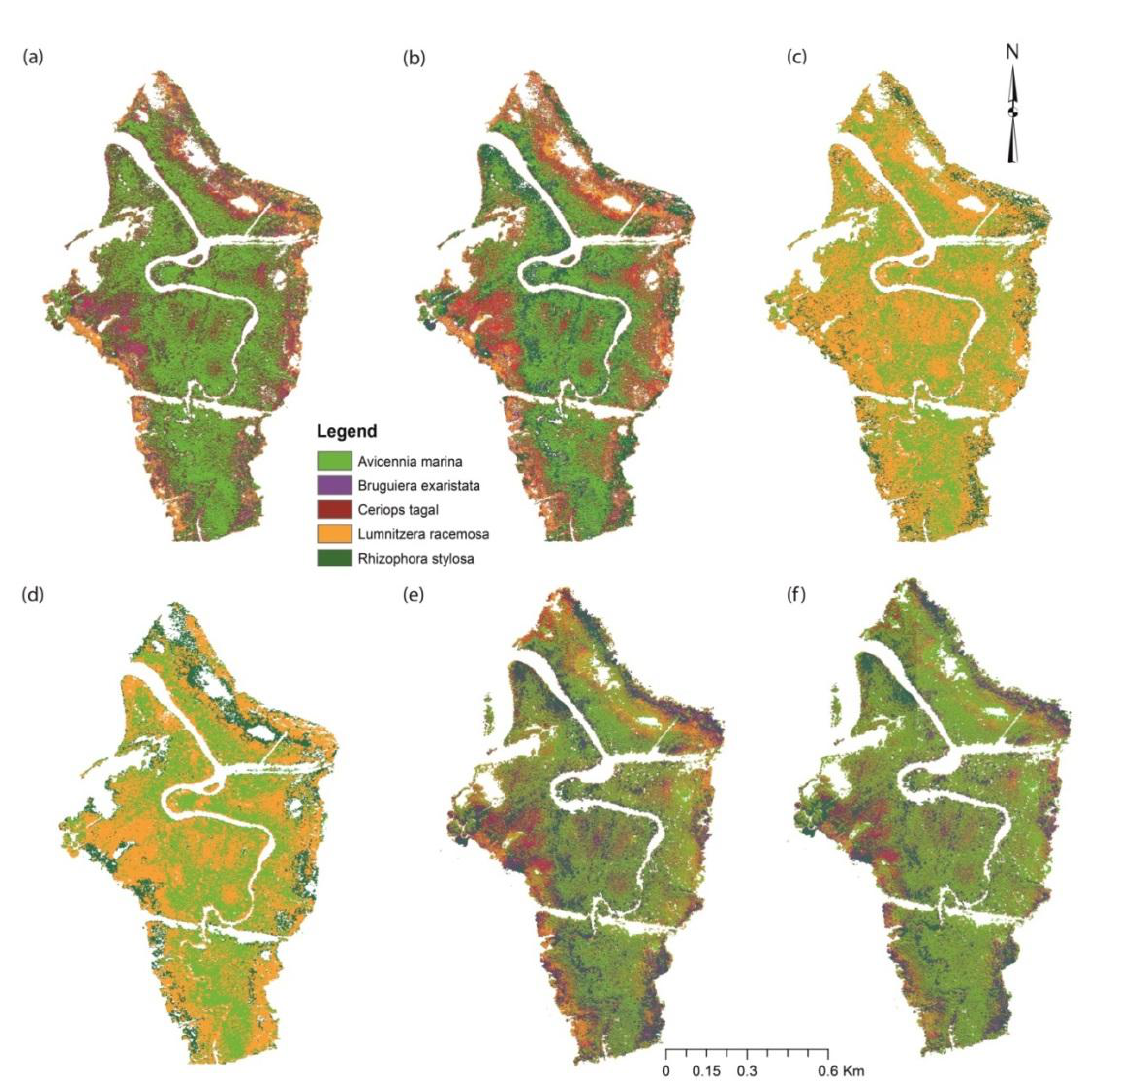
Figure 6. ( a ) Classification of pan-sharpened WV2 image using blue to red-edge bands; ( b ) Classification of pan-sharpened WV2 images using red to NIR1 bands; ( c ) Classification of WV2 image using blue to red-edge bands; ( d ) Classification of WV2 images using red to NIR1 bands; ( e ) Classification of aerial photographs with 0.14 m spatial resolution; and ( f ) Classification of aerial photographs with 0.5 m spatial